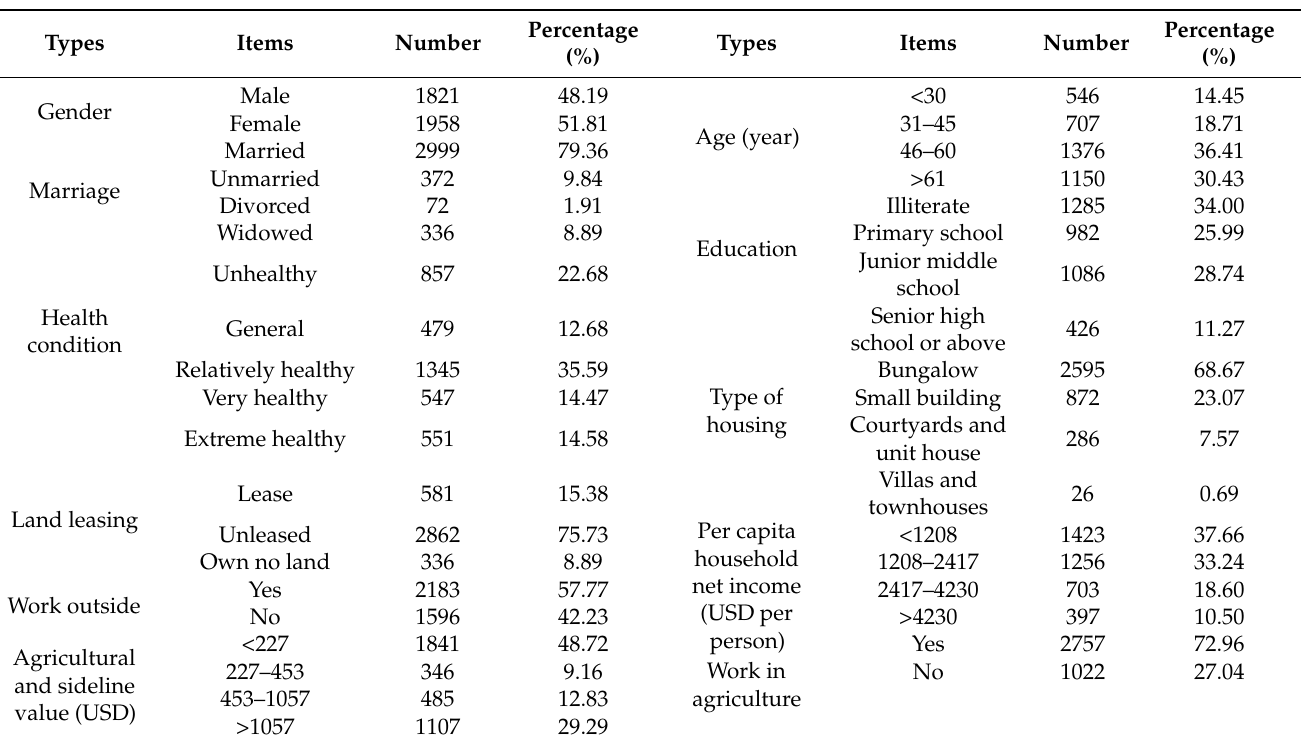
Table 1. Basic characteristics of the